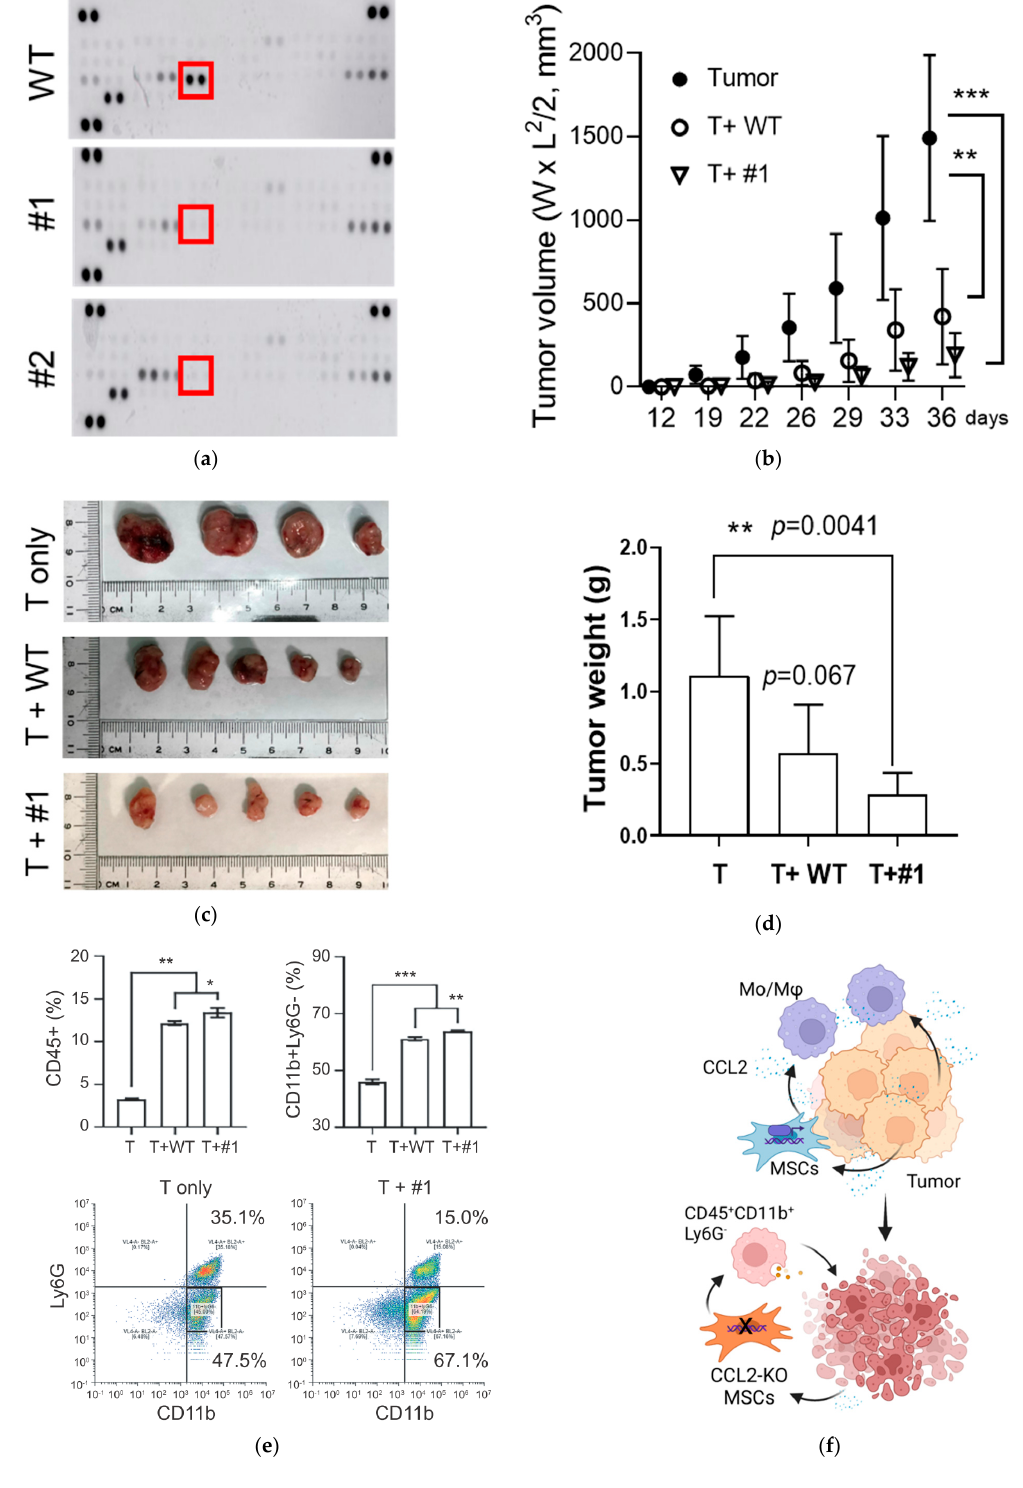
Figure 5. Enhanced anti-tumor effects of the CCL2 knockout (KO) MSCs in vivo. ( a ) Monitoring cytokine/chemokine profiles in C.M. collected from the MSCs (WT) and CCL2-KO MSCs (#1–#2). Red box: CCL2. ( b – d ) Comparison of tumor growth rates in vivo. Immune competent, syngeneic mice (C57BL/6) were co-injected with TRAMP-C2 (T) and MSCs (WT vs. #1). Time course of tumor size [panel ( b )]. Images of the collected tumors from each group [panel ( c )] and final tumor weights [panel ( d )]. ( e ) Immune profile analysis of CD11b + LyG6 − populations in the tumor microenvironment. n = 3. ( f ) A working model. Prostate cancer and MSCs secret CCL2 to recruit monocyte/macrophage (Mo/M φ). Using CCL2-KO MSCs to suppress tumor growth indireclty via CD45 ⁺ CD11b ⁺ Ly6G ⁻ mediated functions. Student’s t -test. * p < 0.05. ** p < 0.01. *** p < 0.001.